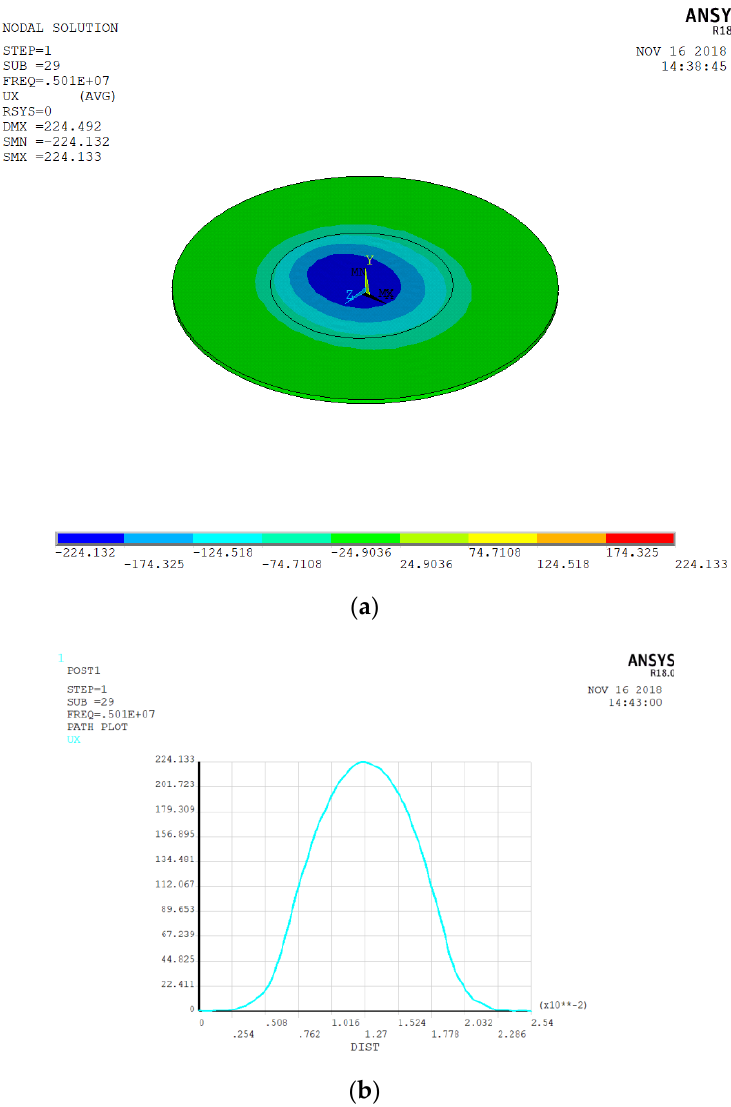
Figure 6. ( a ) The energy-trapping diagram of a circular gold electrode with a radius of 6 mm; ( b ) the vibration displacement curve corresponding to a 6 mm circular gold electrode.